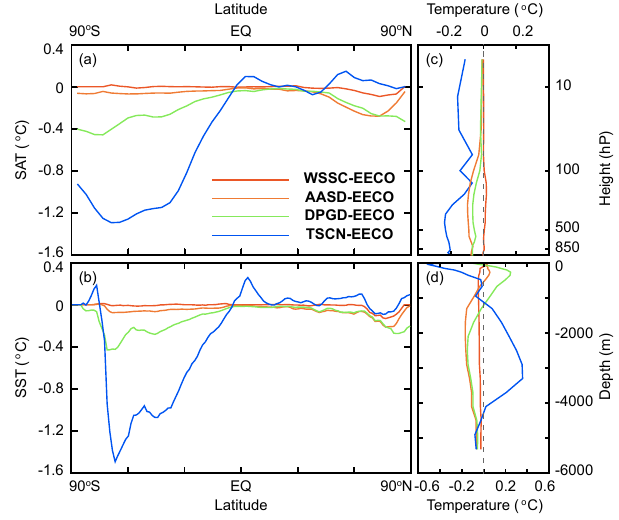
Figure 6: Changes in atmosphere and ocean temperature ( o C) in the four sensitivity Fig. 6. Changes in atmosphere and ocean temperature ( ◦ C) in experiments. (a) Zonal mean SAT anomaly. (b) Zonal mean SST anomaly. (c) Changes of the four sensitivity experiments. (a) Zonal mean SAT anomaly. global mean atmosphere temperature with height. (d) Changes of global mean ocean (b) Zonal mean SST anomaly. (c) Changes of global mean atmo- temperature with depth. sphere temperature with height. (d) Changes of global mean ocean temperature with